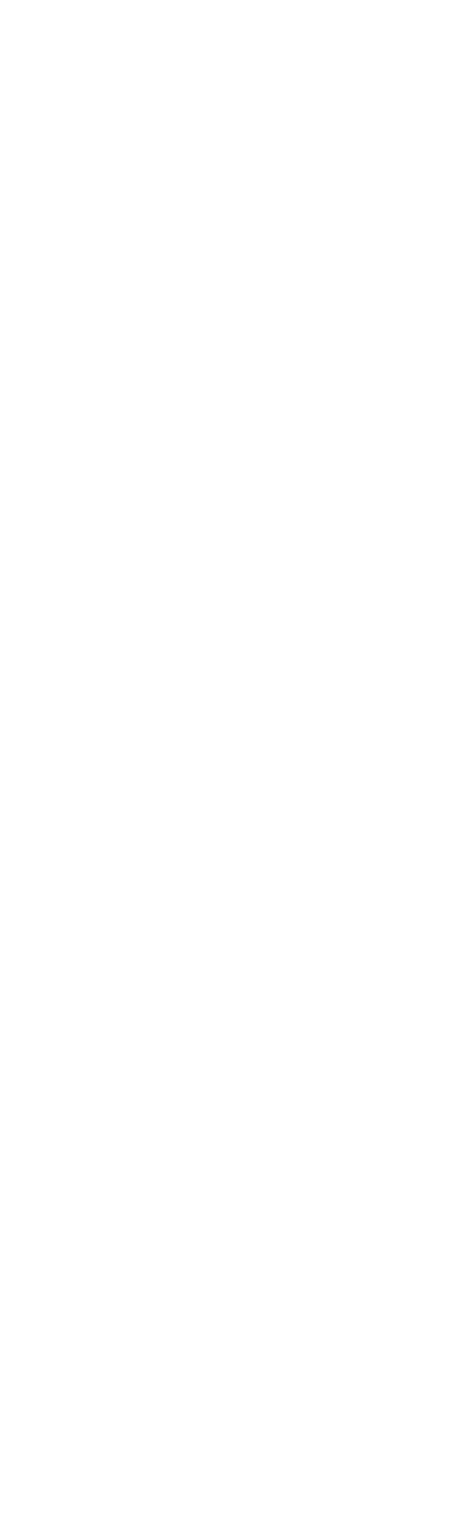
Frontiers in Sustainable Cities |